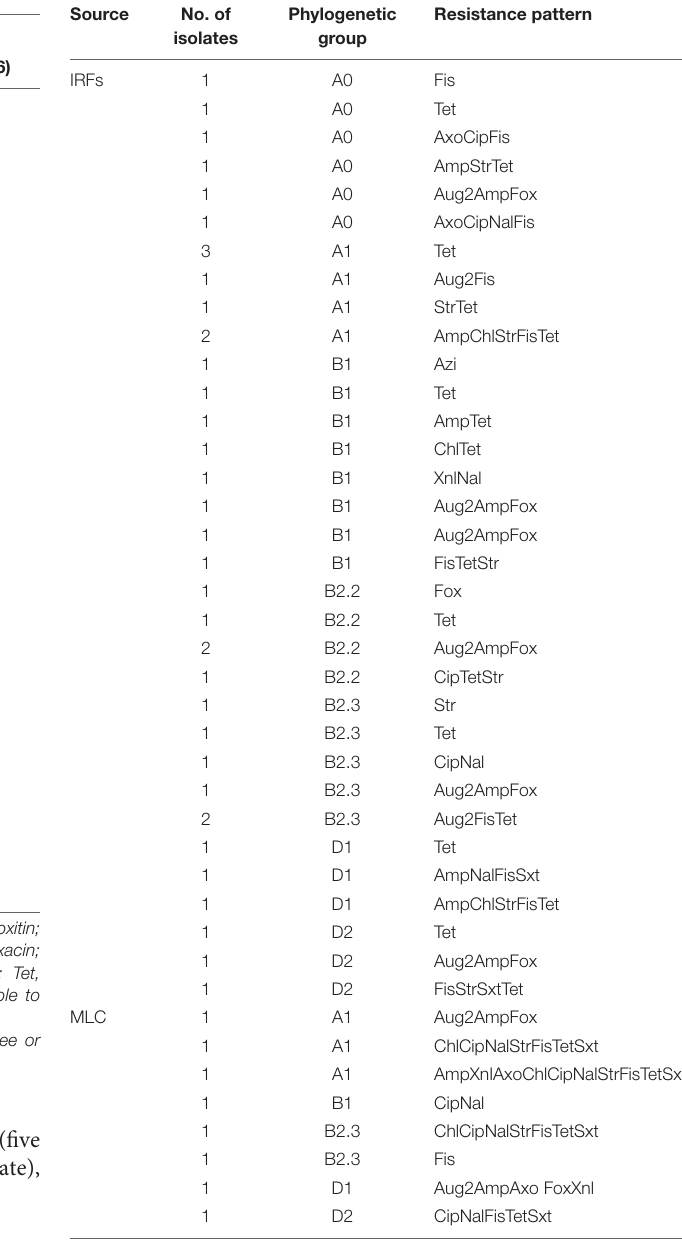
TABLE 5 | Single and multidrug resistance patterns in E. coli from the irrigation return flows (IRFs) and background canal site (MLC). Resistance No. of No. of drug pattern antimicrobials classes